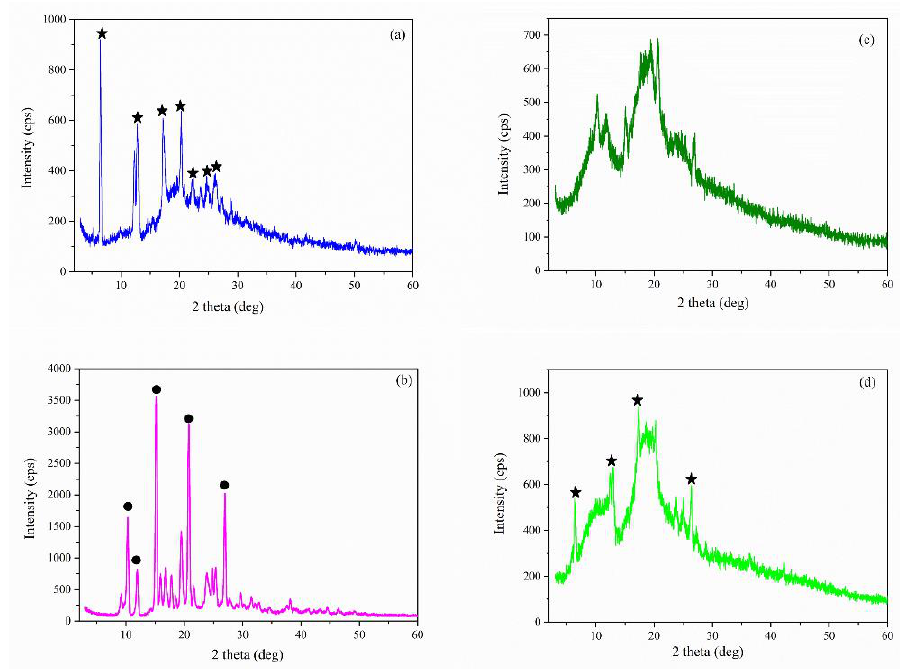
Figure 9. XRD pattern of ( a ) Nim–HP- β -CD physical mixture; ( b ) Nim–HP- β -CD coprecipitation method; ( c ) Nim–HP- β -CD lyophilization method; ( d ) Nim–HP- β -CD kneading method ( —Nim mod I; — Nim mod II).